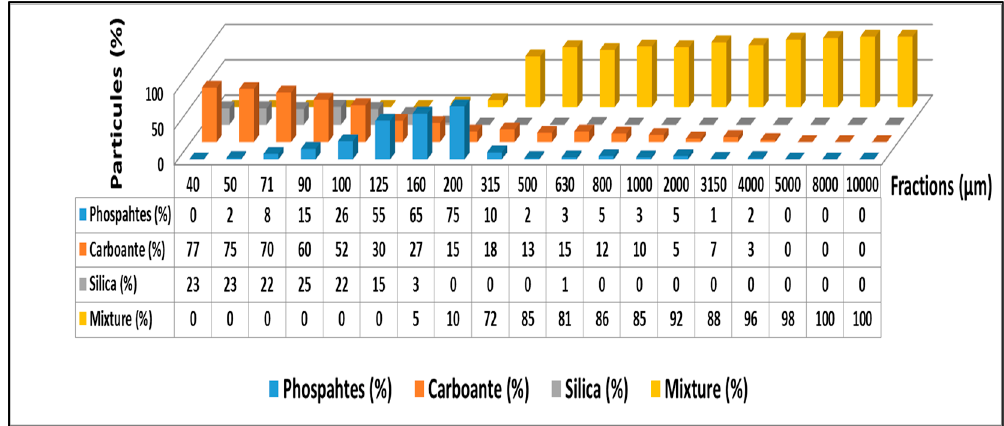
Figure 3. Distribution of the main minerals in different size fractions of the raw phosphate sample.